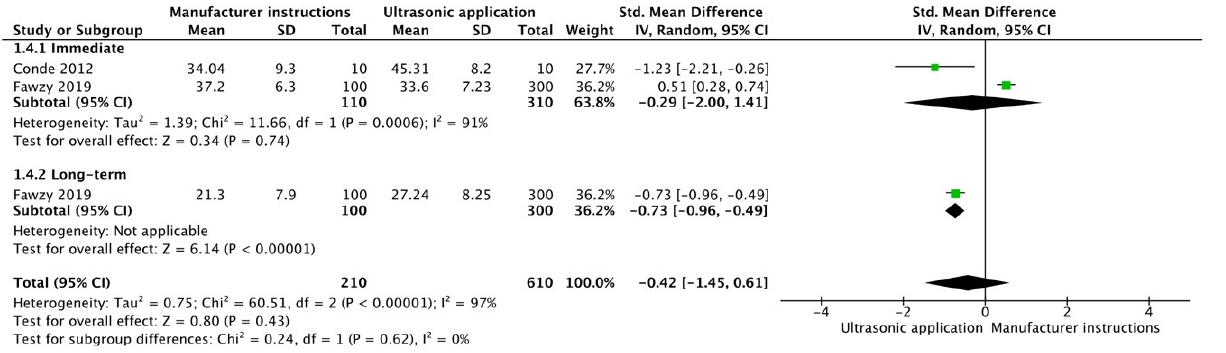
Figure 7. Forest plot showing the bond strength values when the adhesive was applied with an ultrasonic device